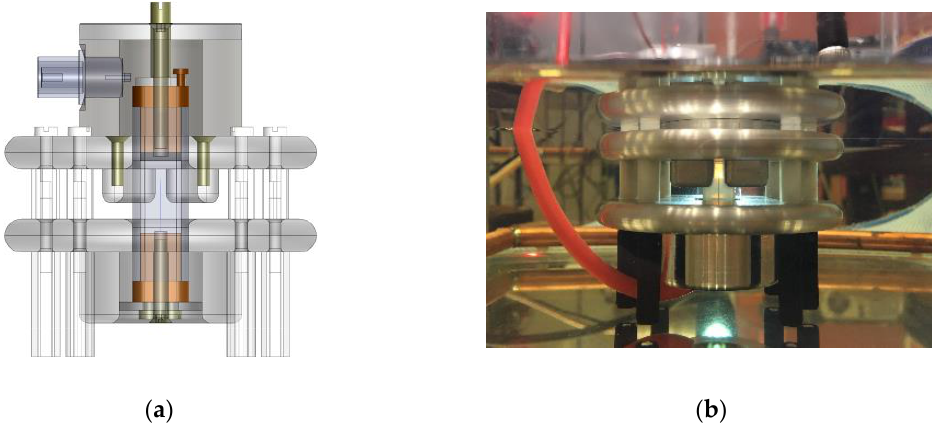
Figure 4. ( a ) A cross section of the cell geometry; ( b ) the finalized cell, submerged in oil.